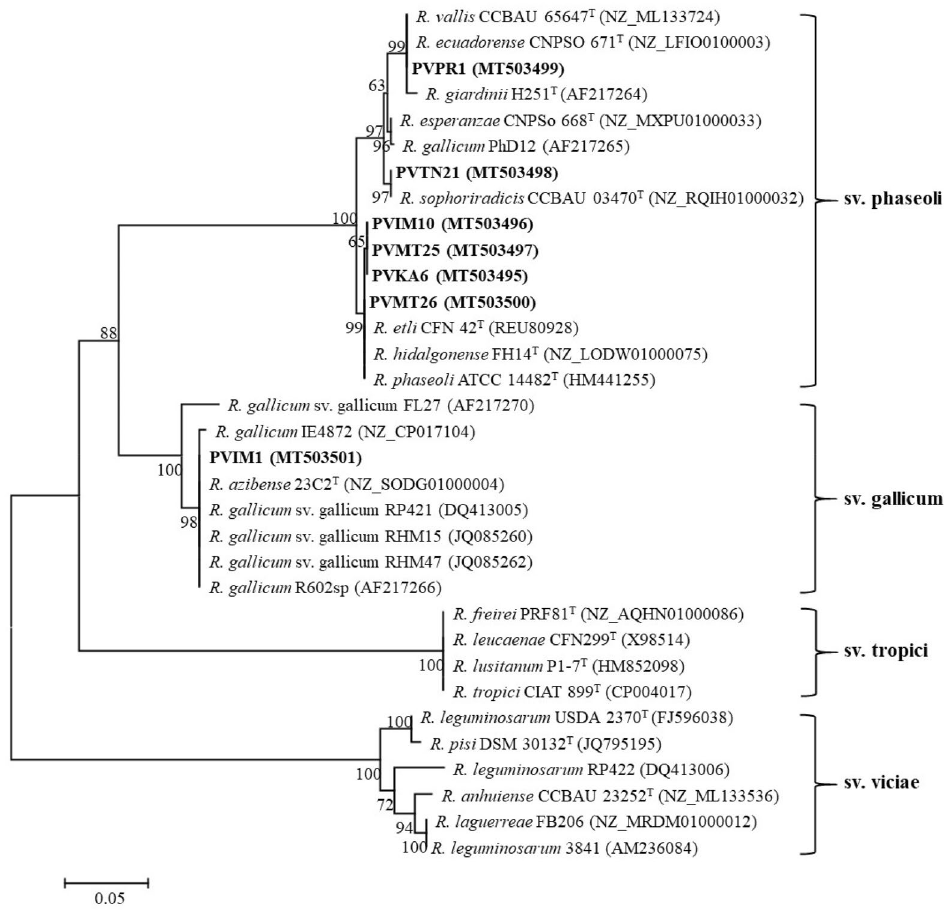
Figure 3. Maximum likelihood phylogenetic trees based on 543-bp alignment of the nodC nucleotide sequences showing the symbiovars to which the strains isolated in this study belong. The taxonomic relationships of the studied strains and the closest type strains of Rhizobium species are shown. Strains isolated in the present study are shown in boldface and their accession numbers are given in Supplementary Table S2. Type strains are indicated by superscript “T” and GenBank accession numbers of their sequences are indicated within parentheses. Bootstrap values (greater than 50%) were calculated for 500 replications and are